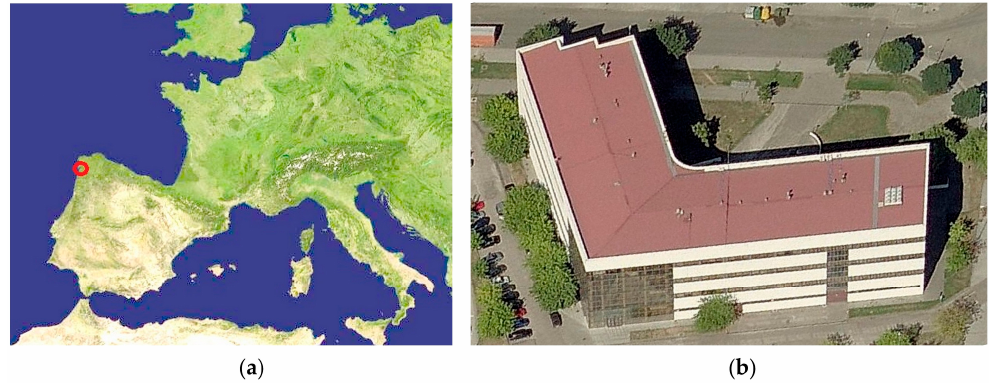
Figure 1. ( a ) Location of Pontevedra (source: www.zonu.com); ( b ) Satellite photograph of Pontevedra Forest Engineering School (source: www.bing.com/maps).